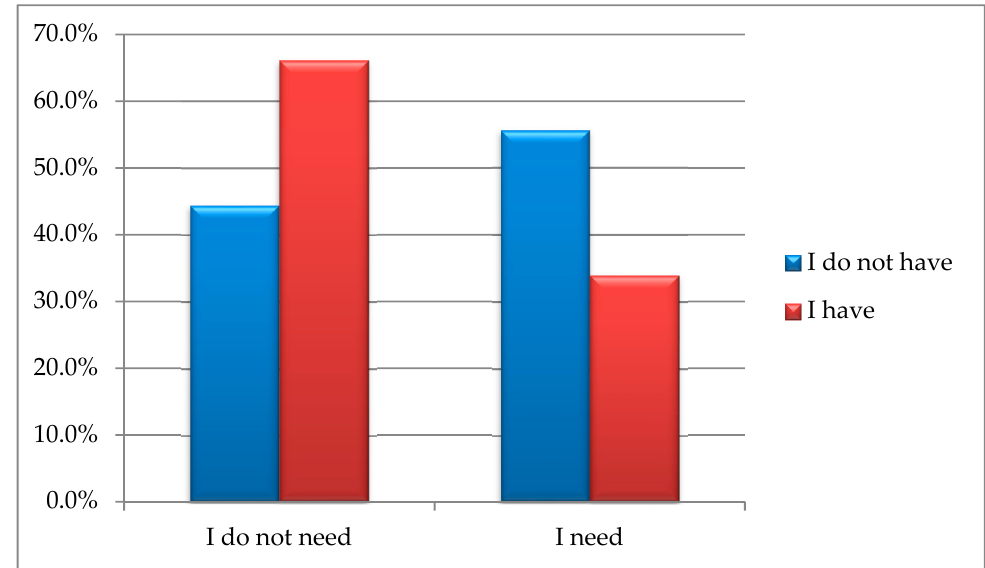
Figure 2. Different available handholds and grippers vs. the actual respondents’ demand for this type of facilities.